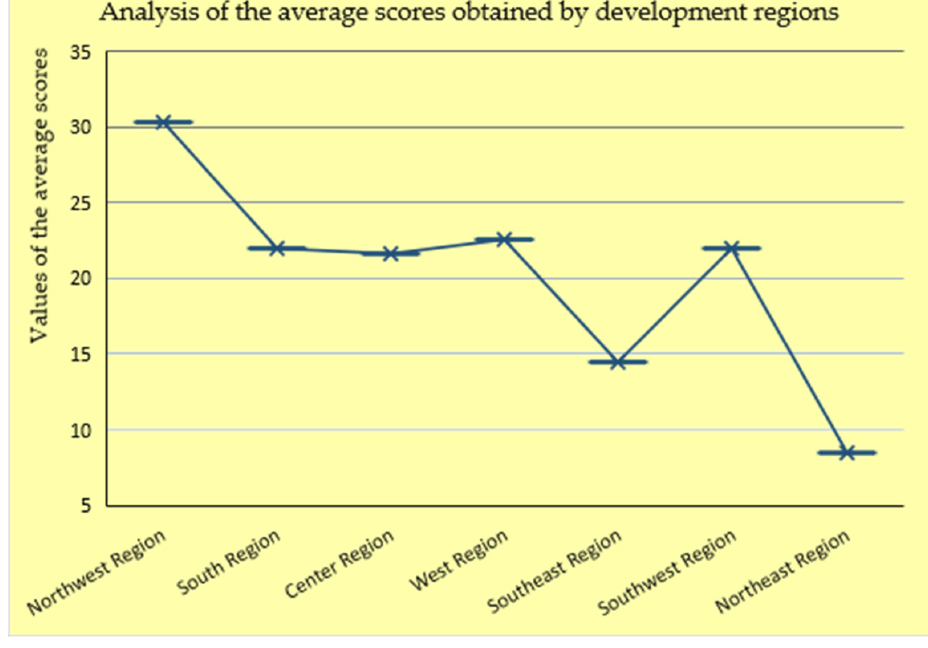
Figure 6. Graphical distribution of the average scores obtained by the regions analyzed (Authors’ own source).